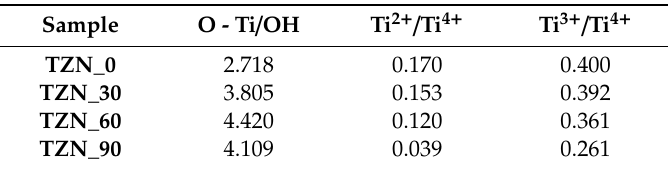
Table 3. Peak area ratios of O-Ti and O-H bonding and the atomic ratios of Ti 2 + and Ti 3 + species with respect to Ti 4 + in the samples.